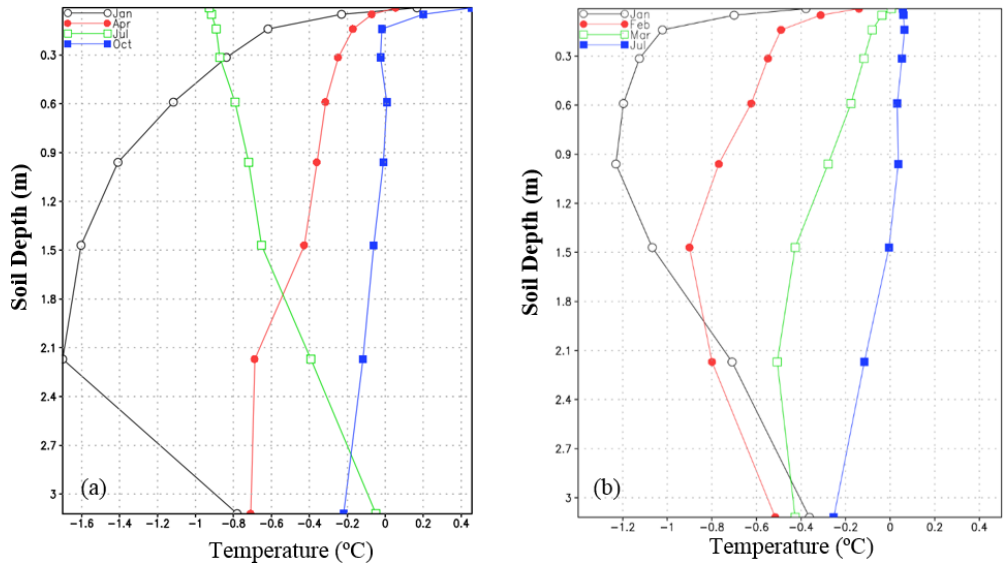
Figure 10. Differences in the seasonal soil temperature profile between the SSiB3-FSMnoICE and SSiB3-FSM for 1981–2005 over (a) the TP (14 sites) and (b) NC (16